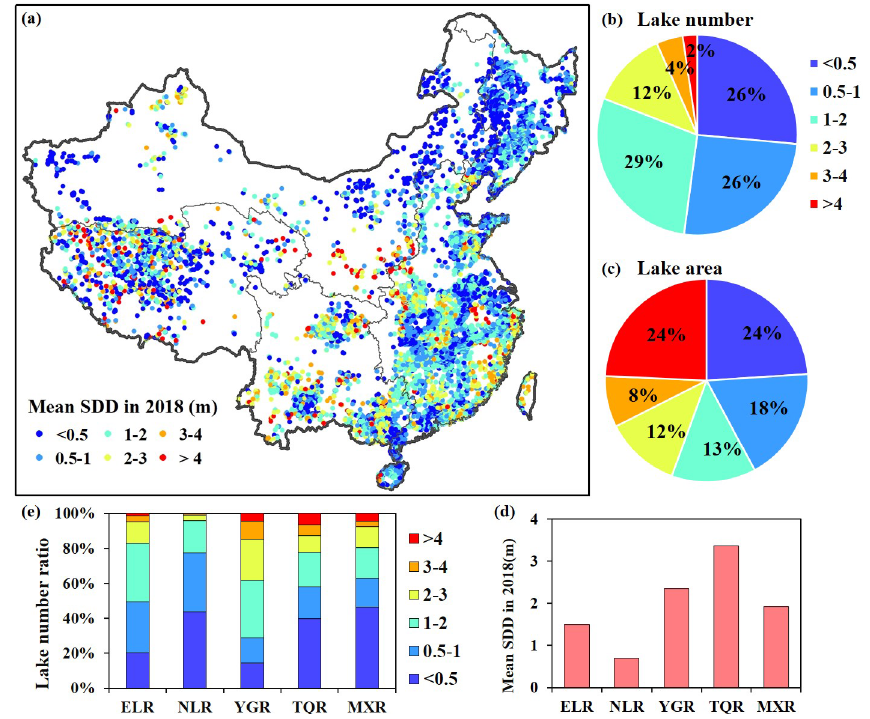
Figure 4. Annual mean SDD of lakes ( > 0 . 01km 2 ) across China in 2018. (a) Spatial distribution of lakes with SDD values. (b) Proportion of the lake number with SDD values for six levels (i.e., < 0 . 5, 0.5–1, 1–2, 2–3, 3–4 and > 4m). (c) Proportion of the lake area for six SDD levels. (d) Annual mean SDDs in the five lake regions. (e) Proportion of the lake number at different SDD levels in the five lake